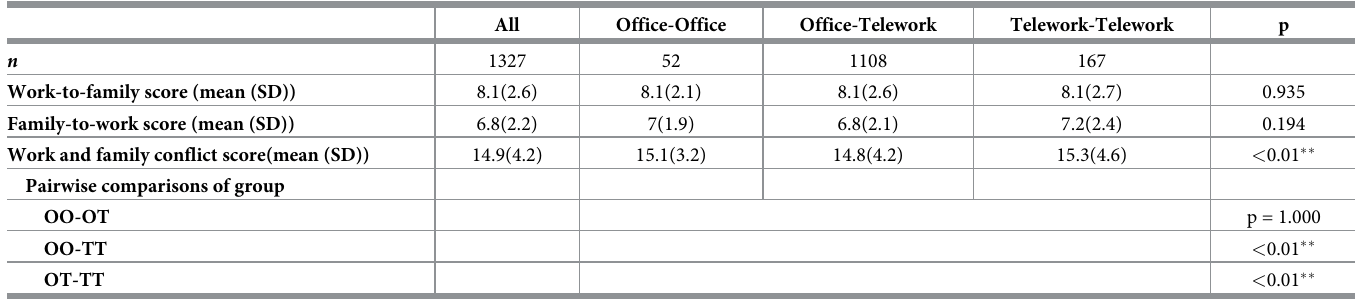
Table 3. Work–family conflict related to telework 1